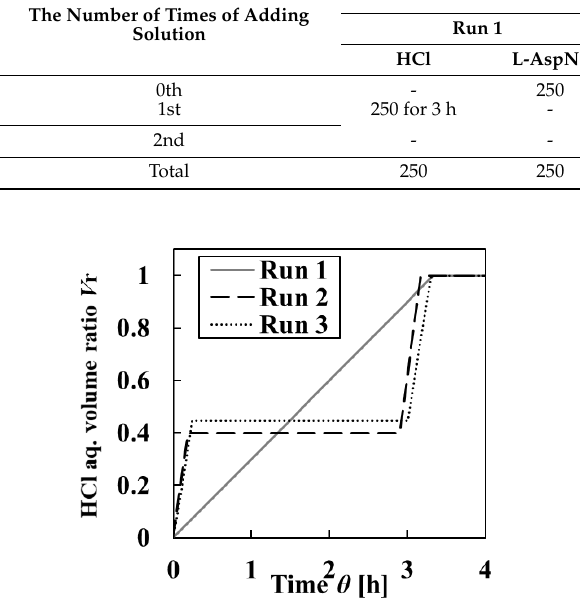
Figure 1. Changes in HCl aq. volume ratio V r against crystallization time. Run 1 contains continuous addition of HCl aq., whereas Runs 2 and 3 contain continuous intermittent addition of HCl